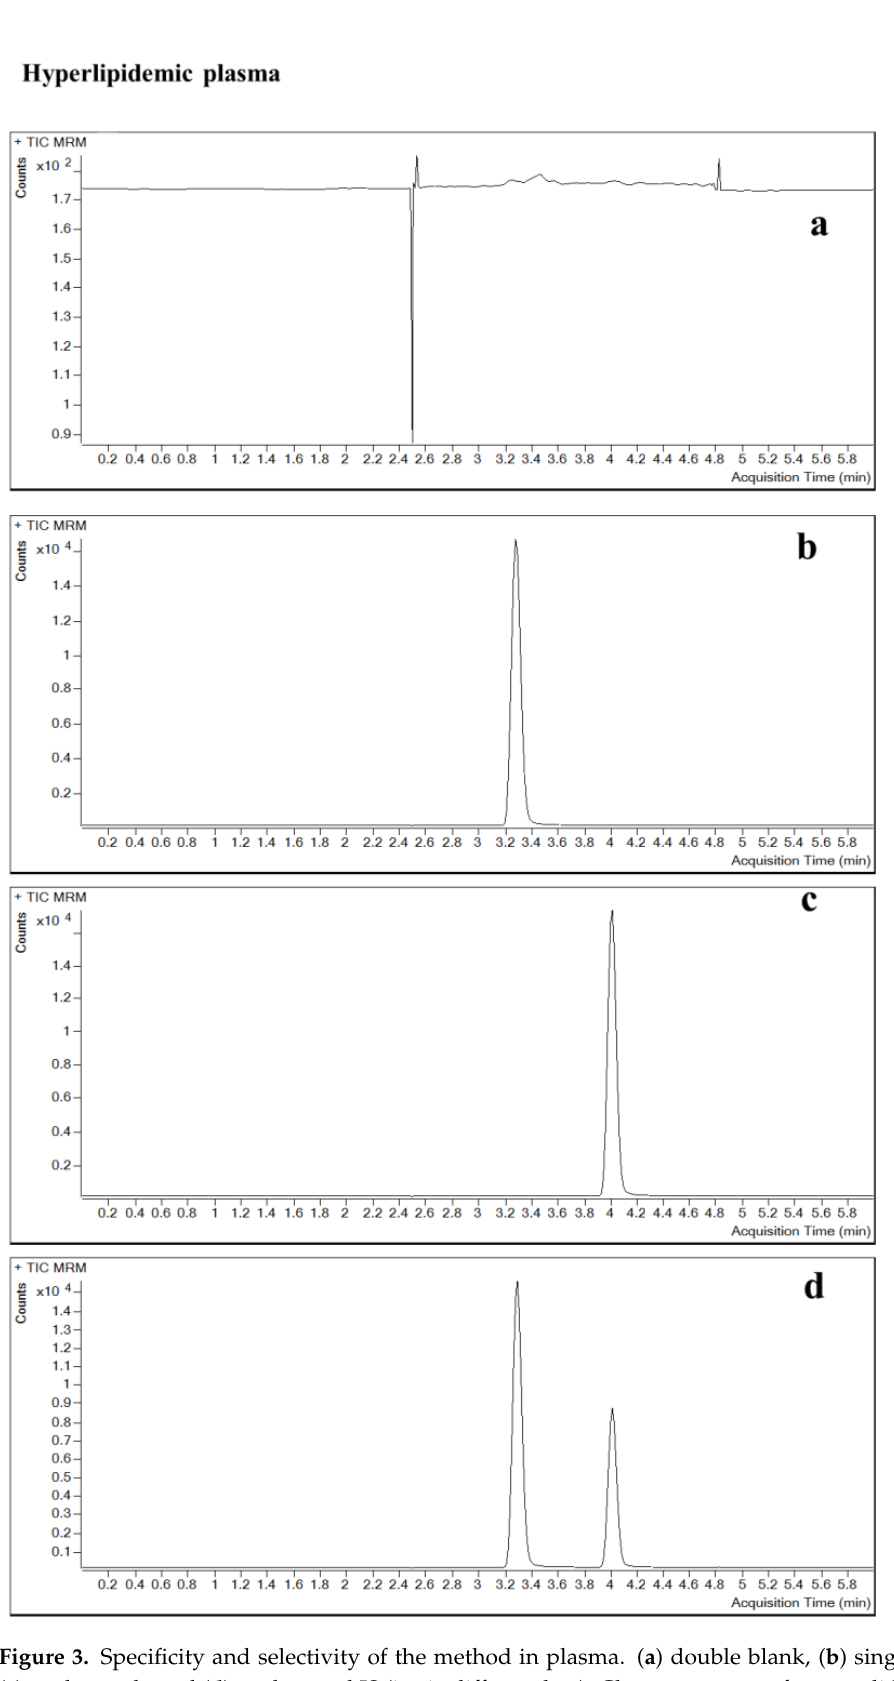
Figure 3. Specificity and selectivity of the method in plasma. ( a ) double blank, ( b ) single blank, ( c ) analyte only and ( d ) analyte and IS (in six different lots). Chromatograms of contezolid ( A ) and linezolid ( B ).